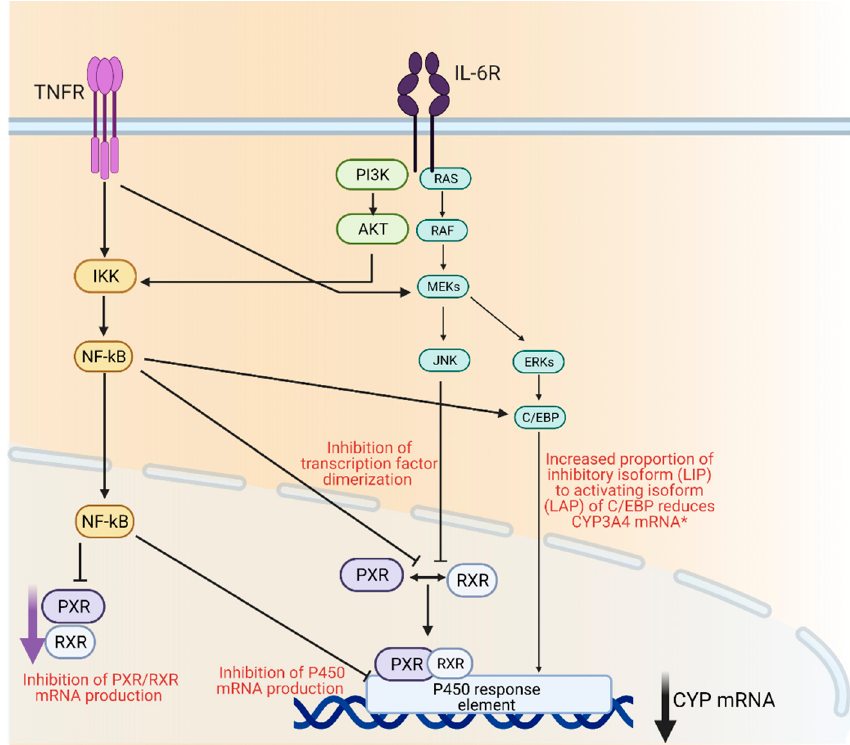
Figure 1. Mechanisms of cytochrome P450 regulation through inflammatory mediators IL-6 and TNF α . AKT; protein kinase B, C/EBP; CCAAT/enhancer-binding protein beta, ERK; extracellular signal regulated kinase, IKK; I κβ kinase, IL-6R; interleukin 6 receptor, JNK; c-jun N-terminal kinase, MEK; mitogen activated protein kinase, Nf- κβ ; nuclear factor kappa light chain enhancer of activate B-cells, PI3K; phosphoinositide 3-kinase, PXR; pregnane X receptor, RAF; rapidly accelerated fibrosarcoma kinase, RAS; small monomeric GTPas, RXR; retinoid X receptor, TNFR; TNF α receptor. Created with BioRender.com.